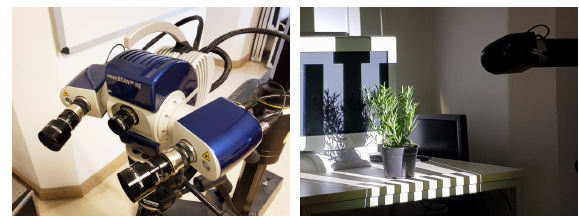
Figure 2. Apply a coded light approach to acquire 3D data of the small plant Rosmarinus officinalis in the